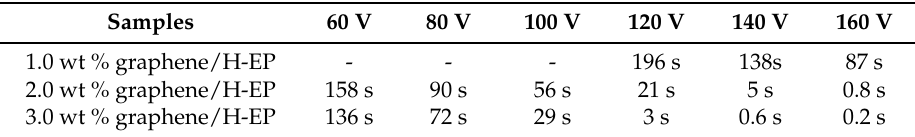
Table 1. Recovery time of the composites under different voltage.